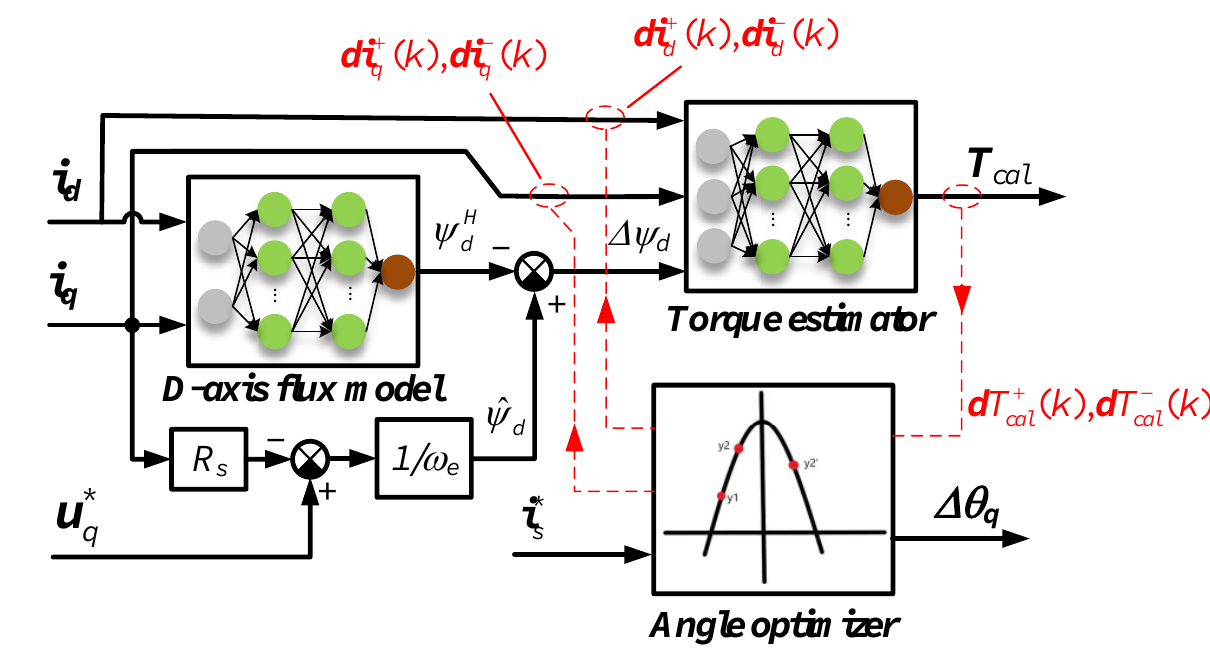
Figure 13. Torque estimation and current angle optimization unit.